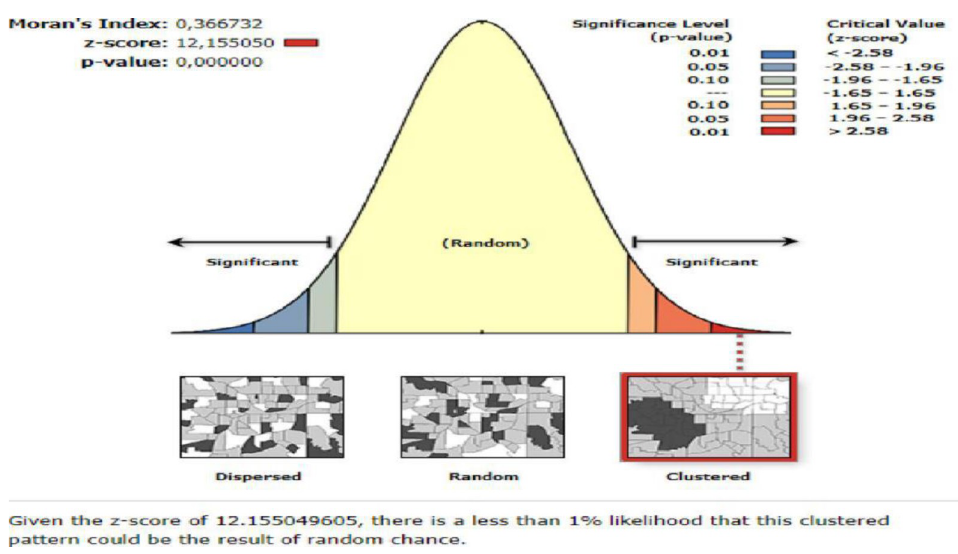
Fig 1. Spatial autocorrelation of undernutrition among reproductive age women in Ethiopia,2016.